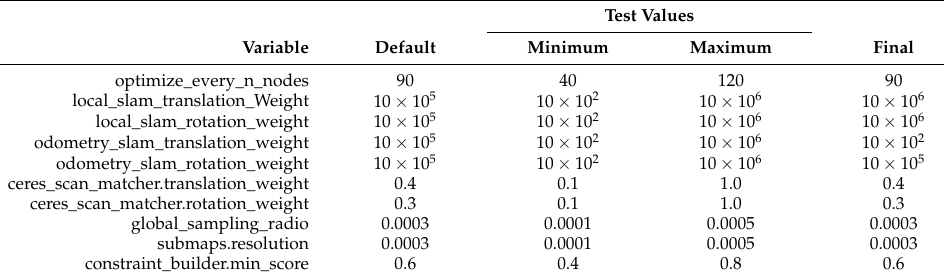
Table 7. Default, tuning and final values for